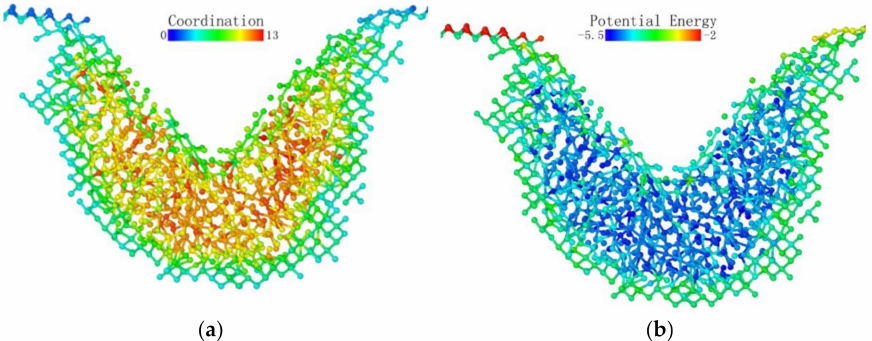
Figure 13. Atomic coordination number distribution (cutoff radius 3.2) and potential energy distribu- tion at a stroke of 3 nm. ( a ) coordination number distribution ( b ) potential energy.